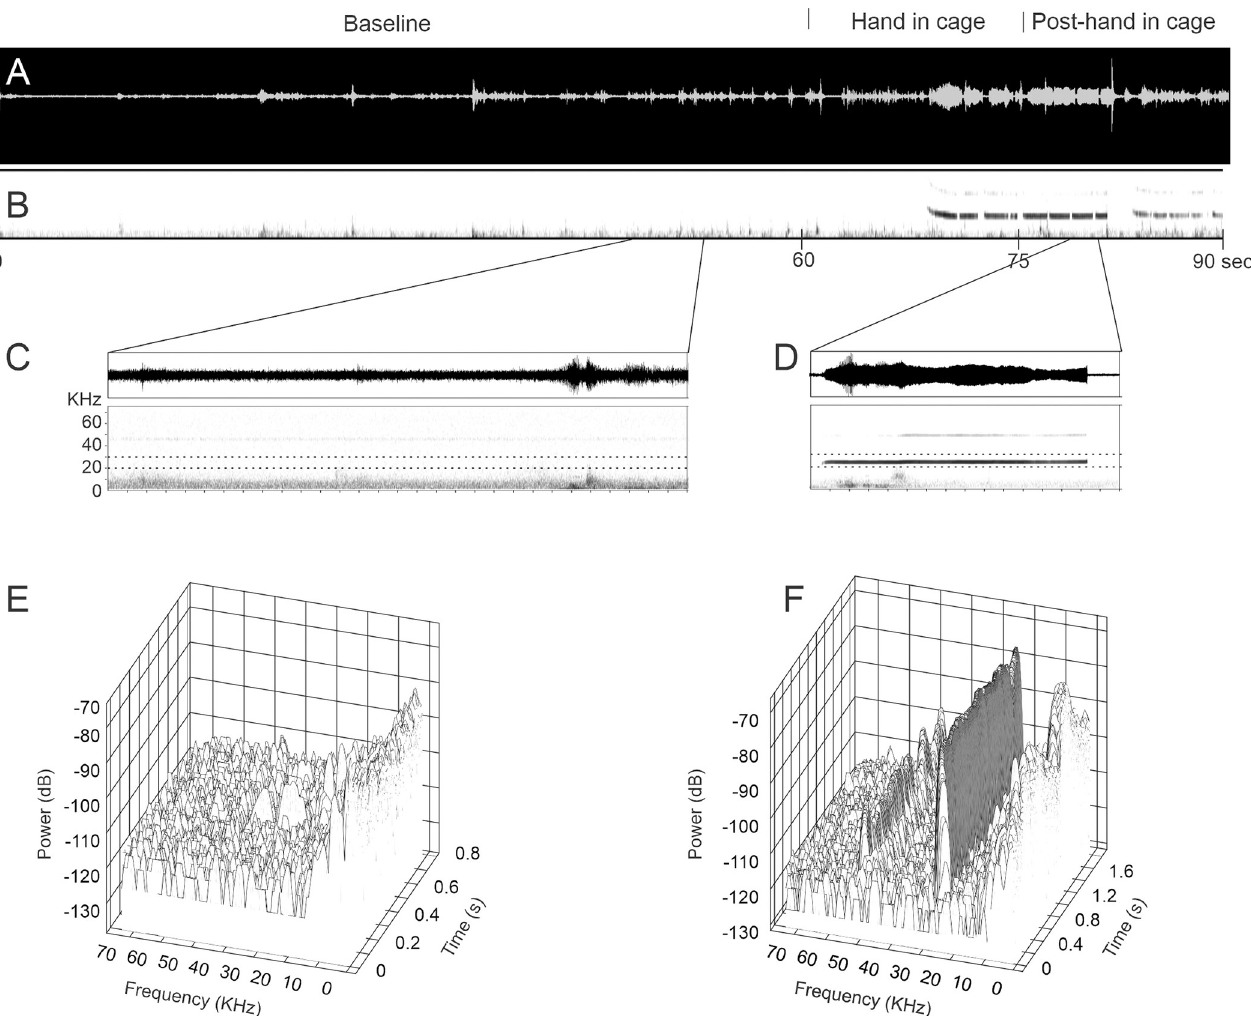
Table 3. ERG parameter comparison (at maximum intensities of 5 dB) between male 22-kHz responders and non-responders. Strains Animal Sprague-Dawley Wistar Han